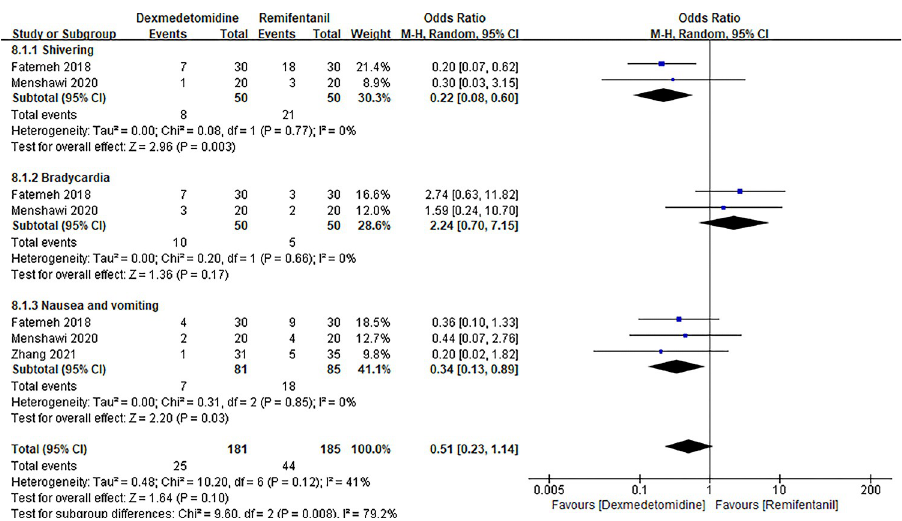
Fig 11. Forest plot of perioperative adverse events. Dexmedetomidine group vs. remifentanil group.